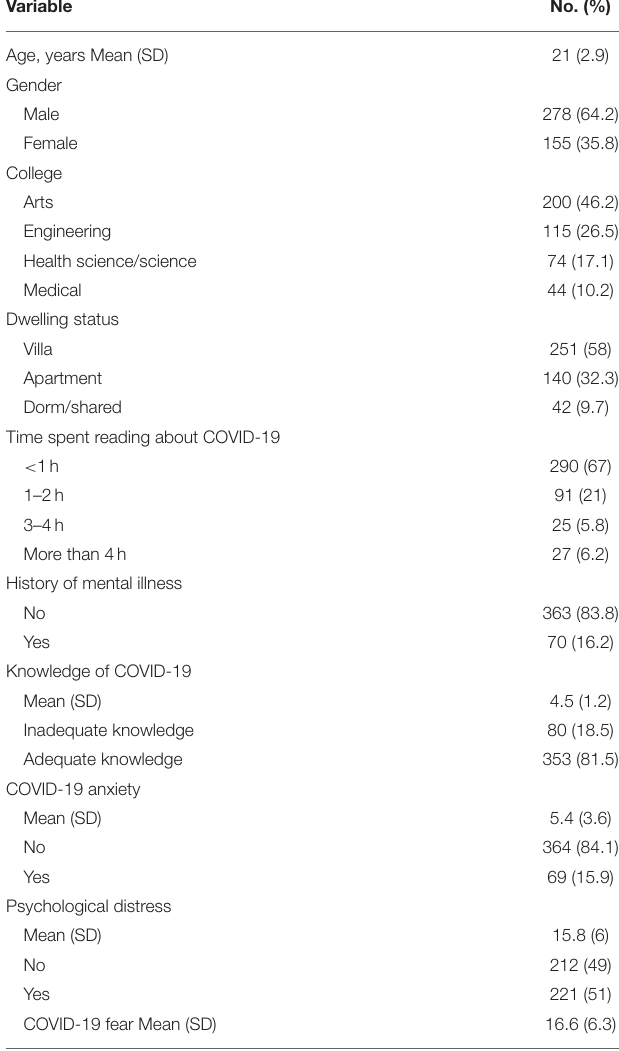
TABLE 1 | Demographic characteristics of participants and their levels of knowledge, anxiety, and psychological distress.